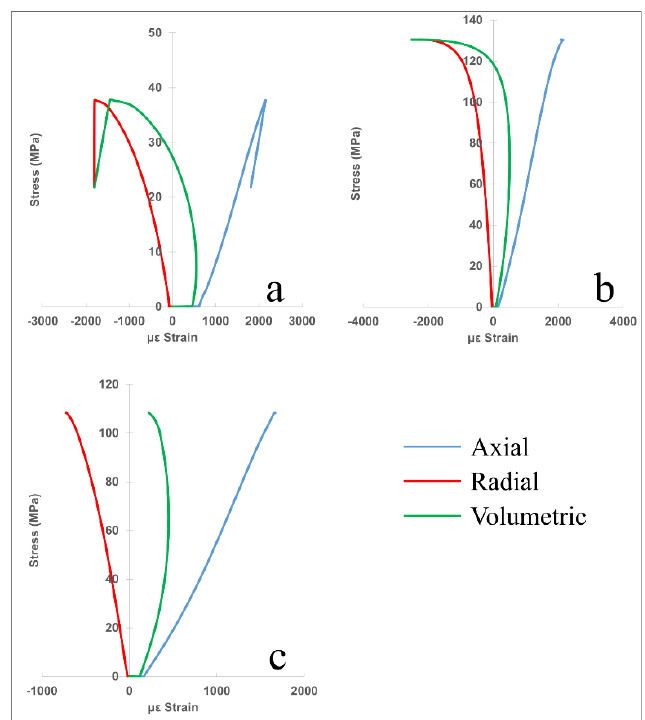
Figure 10. Schematic representations of the stress – strain response and stages of brittle rock fracture process and evolution of the short-term strength of the material to its long-term strength when subjected to a constant stress condition; ( a ) OX-3G, ( b ) OX-4B, ( c ) OX-6C, ( d ) EPN-2B.